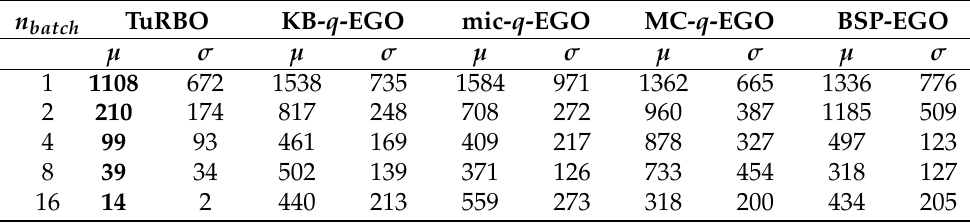
Table 4. Final results in terms of average ( µ ) and standard deviation ( σ ) over 10 execution of each algorithm for the Rosenbrock benchmark function.